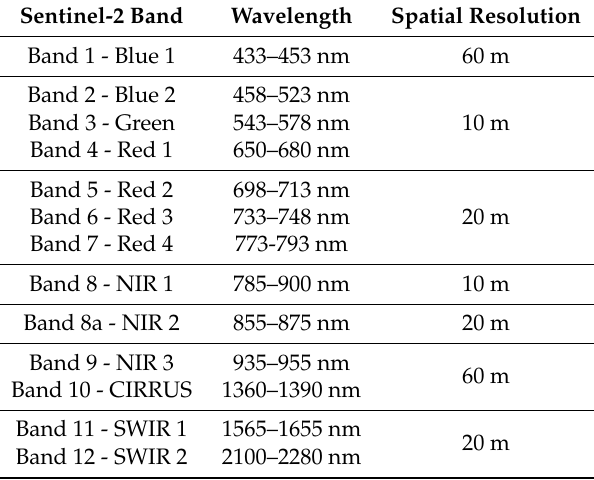
Table A1. Spectral and spatial configuration of